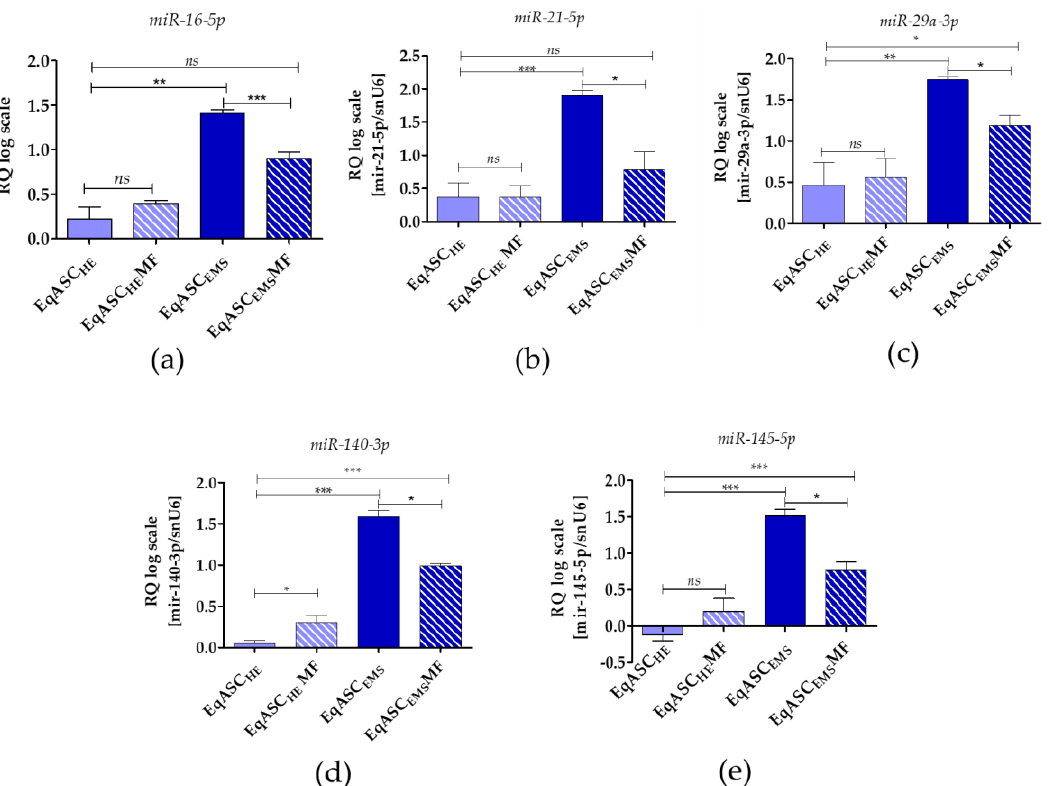
Figure 6. miRNA expression measured with two-tailed RT-qPCR. The following miRNAs were tested: miR-16-5p ( a ), miR-21-5p ( b ), miR-29a-3p( c ), miR-140-3p ( d ) and miR-145-5p ( e ). Data are normalised to U6 snRNA levels and expressed as fold changes compared to the sample with the lowest level. Statistically significant changes are indicated with asterisks: * p < 0.05; ** p < 0.01 and *** p < 0.001, while non-significant differences are marked as ns .